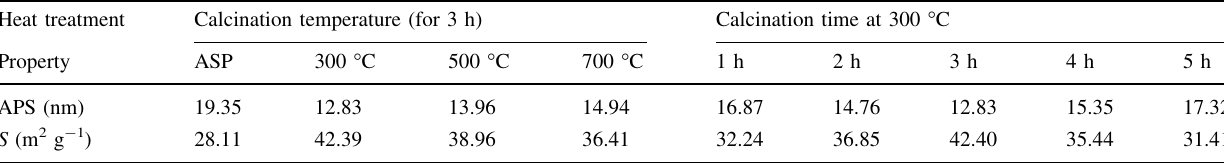
Table 1 Properties of the prepared BMNAs by XRD Heat treatment Calcination temperature (for 3